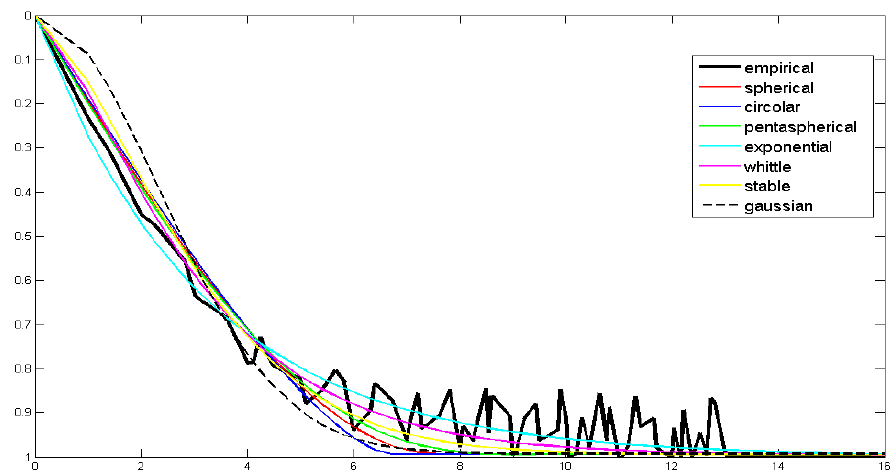
area, the correlation is evaluated and the best covariance kernel is identified.